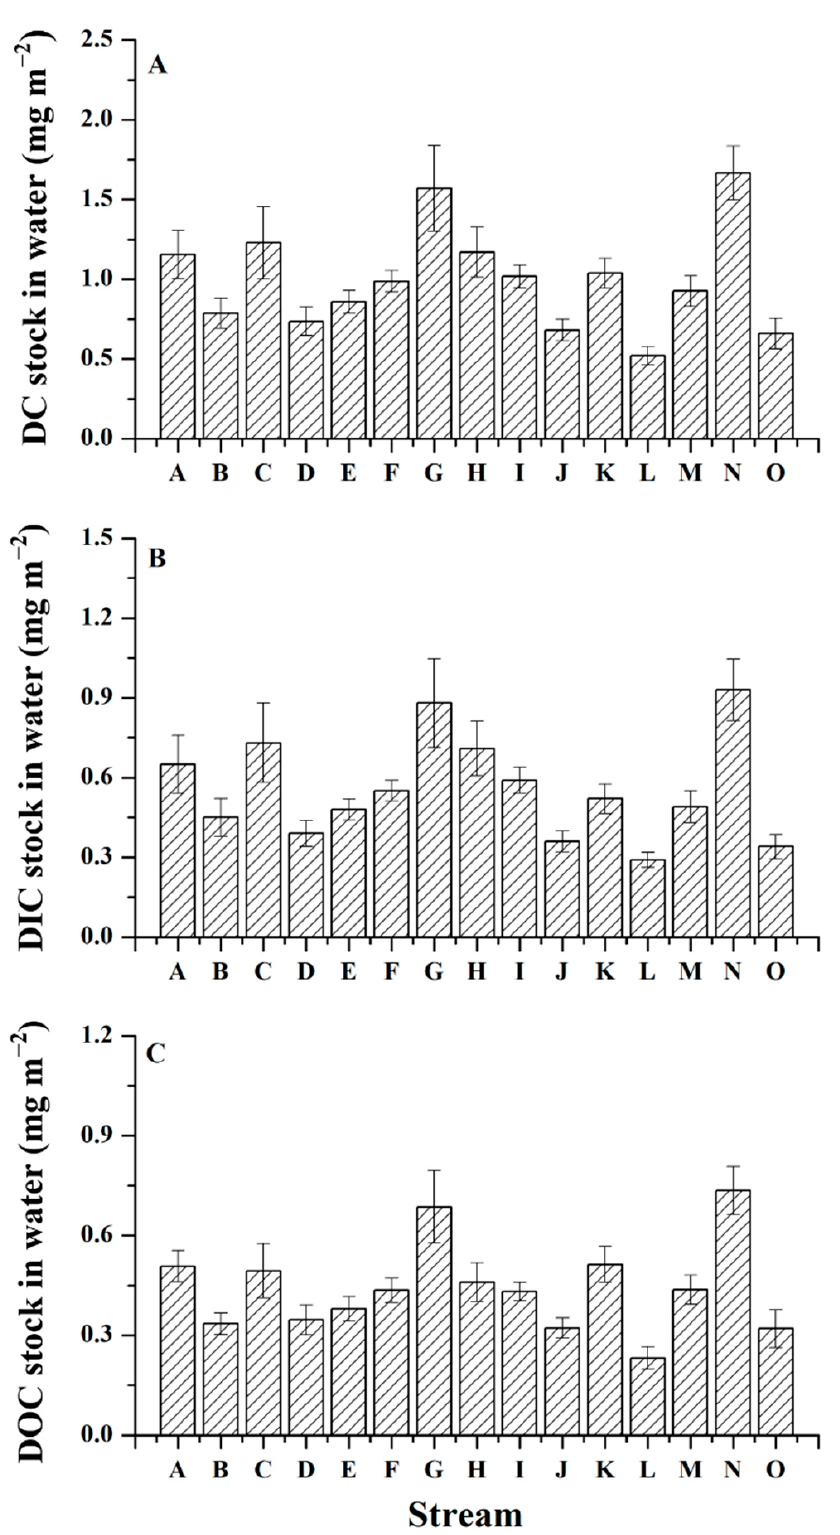
Figure 2. Dynamics of the dissolved carbon stock (DC), dissolved inorganic carbon stock (DIC), and dissolved organic carbon stock (DOC) in the subalpine forest streams in the upper reaches of the Yangtze River. Dissolved carbon stock (DC, ( A )); dissolved inorganic carbon stock (DIC, ( B )); dissolved organic carbon stock (DOC, ( C )). Each bar is the average of 13 sampling times for each forest stream. A–O are the sampled streams in the